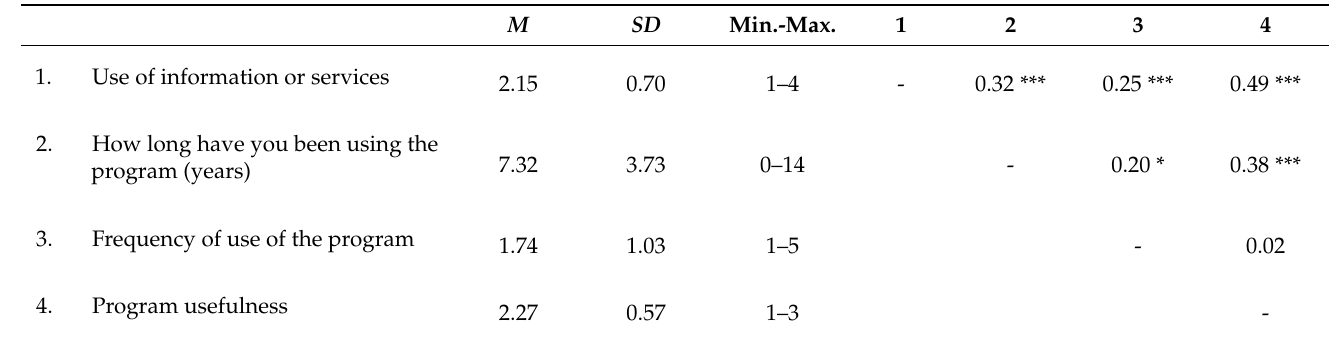
Table 2. Descriptive and correlation matrix of process outcomes of the JAF programme in the intervention group ( n = 142).